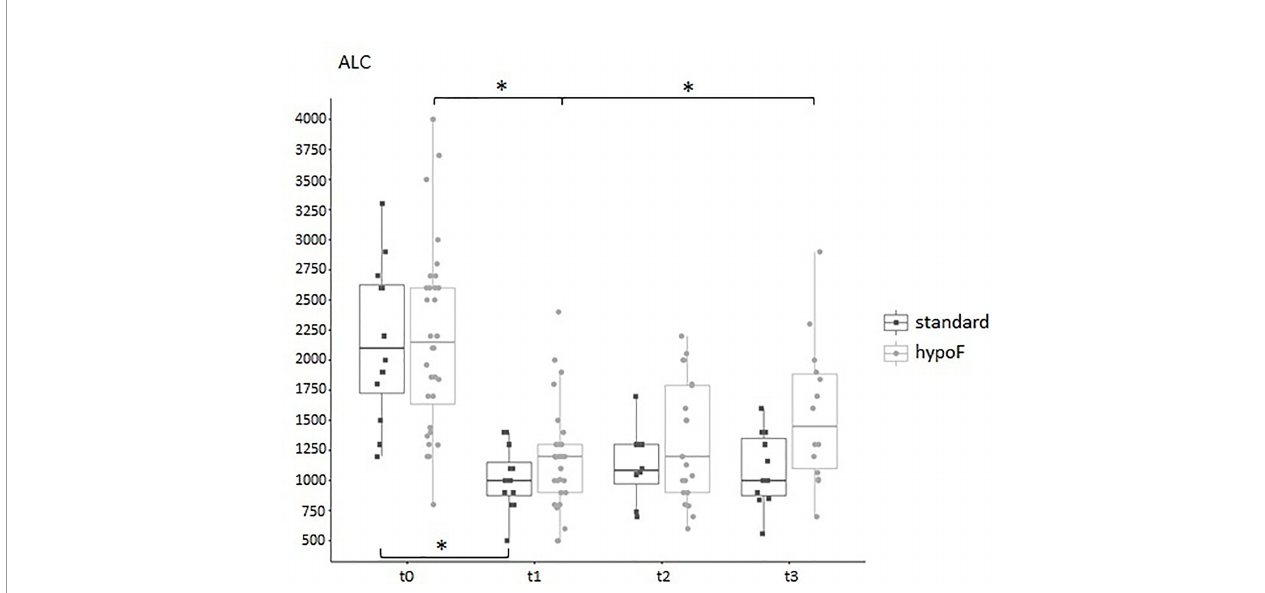
FIGURE 5 | Boxplot of the absolute lymphocyte counts, expressed as cells/µl, in standard ( n = 12) and hypoF ( n = 32) RT groups of patients during the four time points considered. Statistically signi fi cant differences were marked (Wilcoxon test, *adjusted p -value <